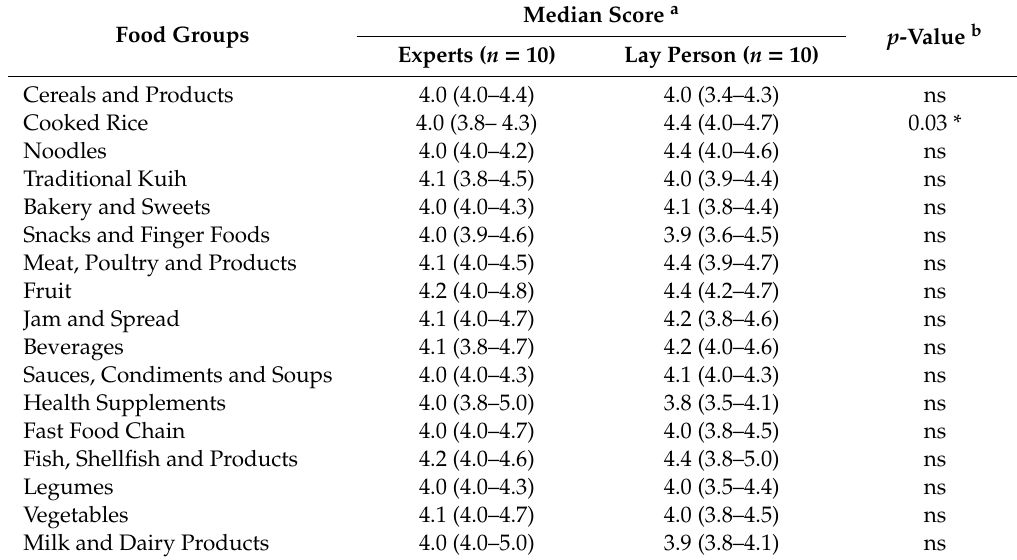
Table 1. Individual food group scores as per experts and lay